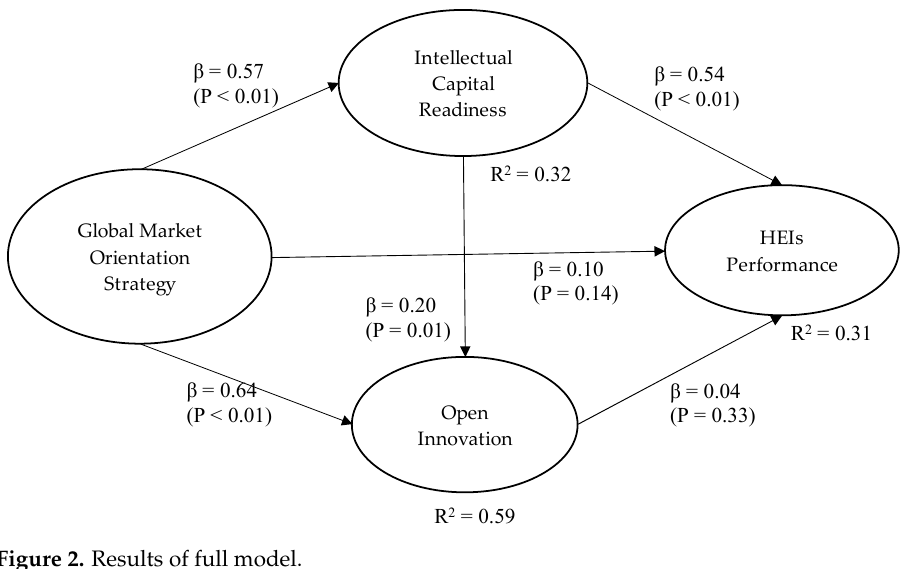
Figure 2. Results of full model.